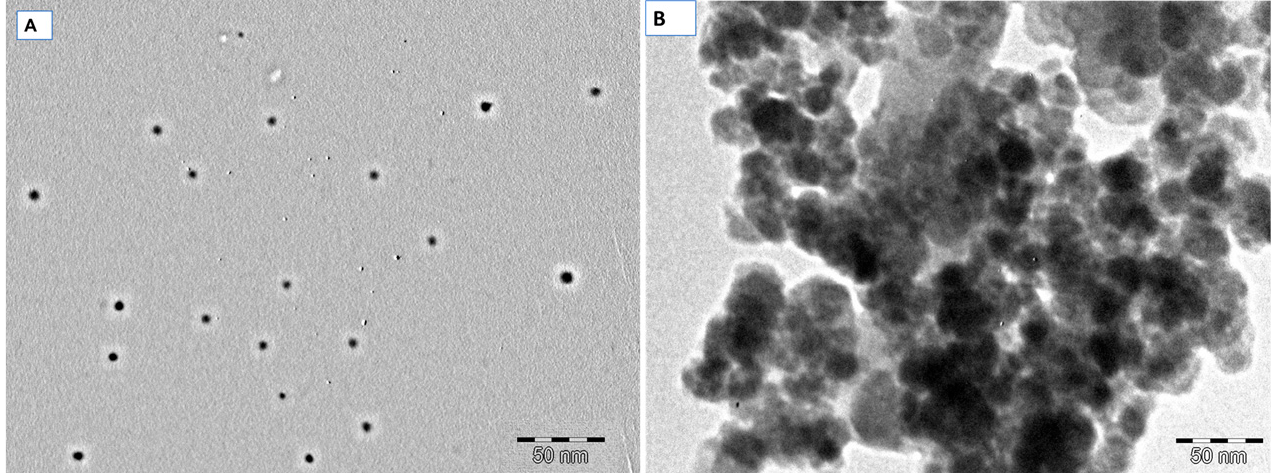
Figure 2. Morphological and size variations of the ( A ) PEG-CuAuNPs and ( B ) AlClPcTS41-PEG- CuAuNPs through the transmission electron microscope.